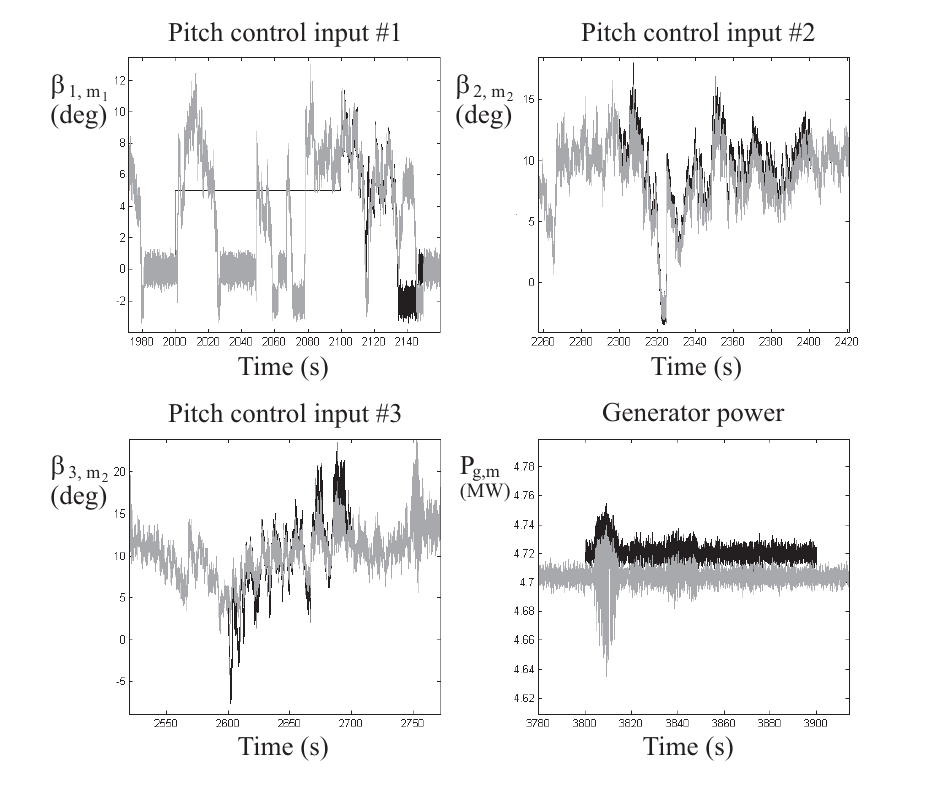
Figure 10. Pitch sensor measurements β i , m j and generated power P g , m in full load